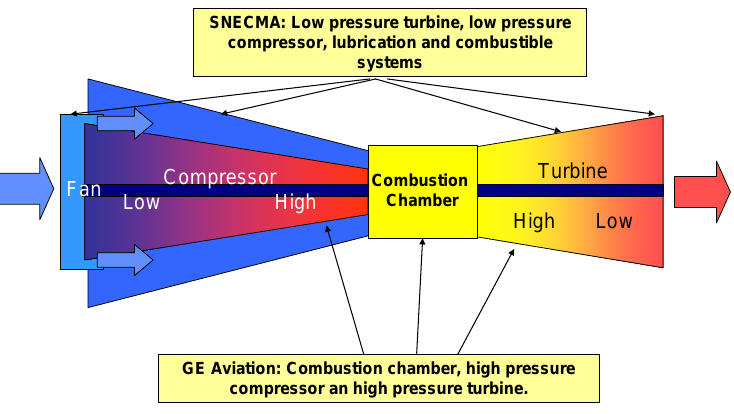
Figure 7. “Schematic of CFM 56 engine collaborative manufacturing between SNECMA and